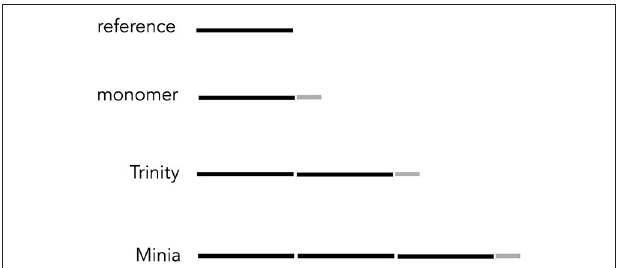
FIGURE 5 | Schematic linear representation of resultant contigs assuming that defect concentrated at the end of gene A. A monomer contig consisted of nearly a whole part of the reference (black) and a region mixing the rest of the reference and defects (gray). Trinity contigs included another complete reference. Minia contigs contained two perfect copies of the